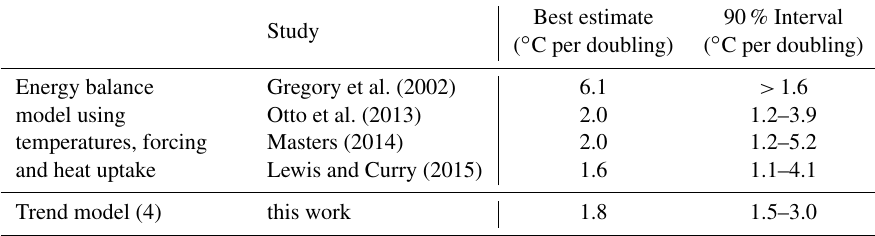
Table A1. Comparison of estimates of a sensitivity parameter from studies that use observational data and a simple energy balance approach. The large best (median) estimate from Gregory et al. (2002) is due to a very fat right tail in their analysis; the mode of their distribution is 2.1 ◦ C per doubling. The estimates given in these studies are similar to our estimates of λ A (which should be smaller than the equilibrium